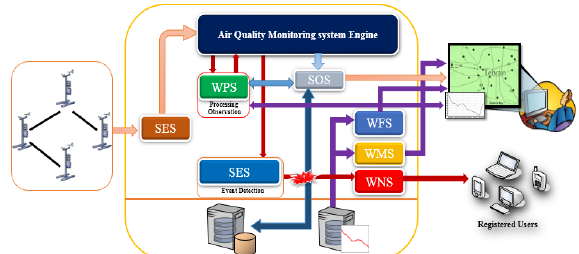
Figure 1. Air Quality monitoring system Standard component and their